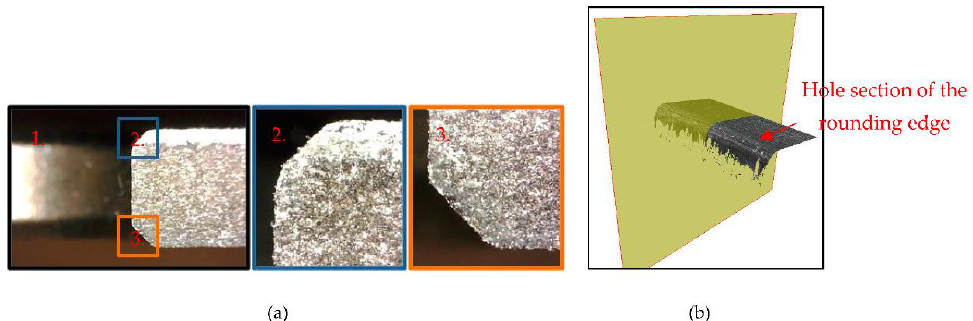
Figure 6. ( a ) Hole section and detail of the chamfer and rounding edge. Image 1 (5×), Image 2 (10×), Image 3 (10×). ( b ) Angle detail measured with optical means of the rounding edge of a hole section (5×). Table 3. Angle detail—hole section of the rounding edge.